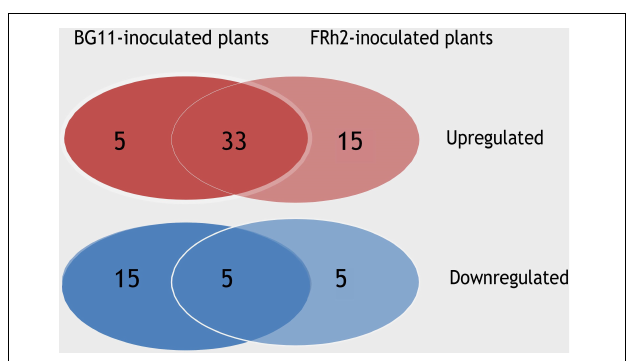
FIGURE 3 | Venn diagram comparing the expression patterns of the shared differentially expressed genes (DEGs) between FRh2- and BG11-inoculated